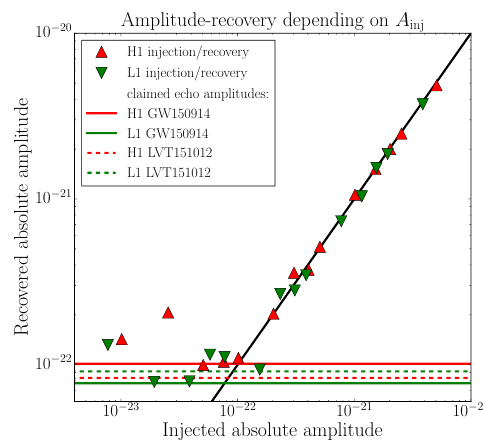
Figure 31. In this plot echoes signals are injected into Gaussian noise and are analysed for different FIG. 4. Injections of echo signals into Gaussian noise are anal- ysed for different amplitudes of the injection. For injections overall amplitudes A [23]. Injection amplitudes above 10 − 22 of the peak strain, can be accurately with amplitudes above 10 − 22 of peak strain, the recovered recovered. For the injections with lower amplitudes no matter what value they take, recovered values are close to the injected ones, indicated by the diago- nal line. For injections with lower amplitudes, the recovered amplitudes are likely to be around 10 − 22 . Horizontal lines show the amplitudes reported in [18]. amplitudes are around 10 − 22 , independently of the injected The injections are made with γ = value. The amplitudes found in [20] are shown as horizontal lines (“true” values unknown) and are similar to the values incorrectly recovered for low amplitudes. The shown injec- tions are made with γ = 0 . 8, with similar results for other values.